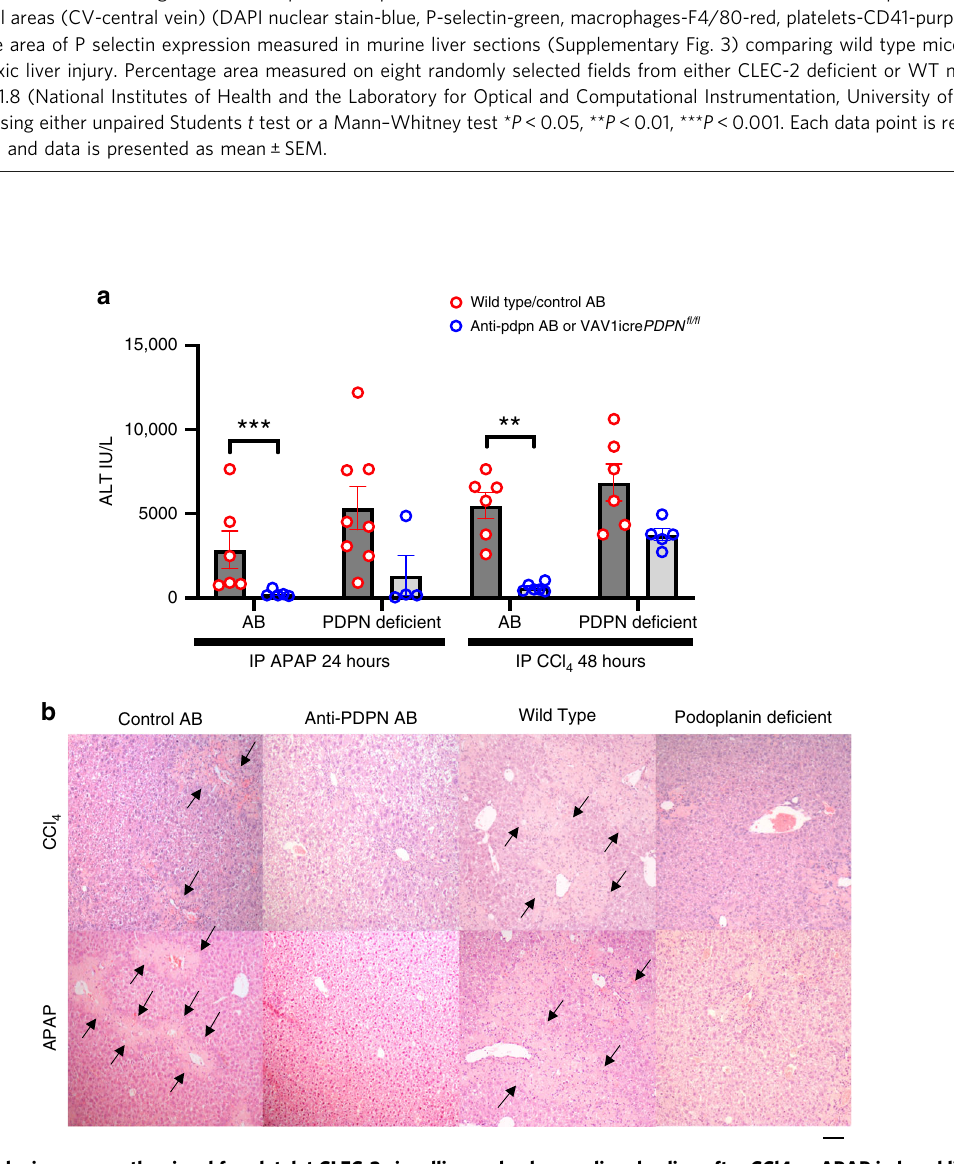
Fig. 2 Mice with CLEC-2 de fi cient platelets ( CLEC1b fl / fl Pf4Cre) exhibit reduced hepatic platelet sequestration and enhanced liver healing after a toxic injury. Wild type (Cre negative) or CLEC-2 de fi cient ( CLEC1b fl / fl Pf4Cre) Mice were injected with IP CCl 4 (1 mg/kg) or IP APAP (350 mg/kg) and sacri fi ced 24, 48 or 72 h (IP CCl4) or 6, 24, 48 h (IP APAP) after injection. For uninjured controls, (both wild type and CLEC-2 de fi cient) mice were injected with mineral oil (MO) or phosphate buffered saline (PBS) alone. a Serum alanine transaminase activity at different time points comparing wild type with CLEC1b fl / fl Pf4Cre mice injected with IP APAP ( n = 4 – 8 at point of peak injury). b Serum alanine transaminase activity at the different time points comparing